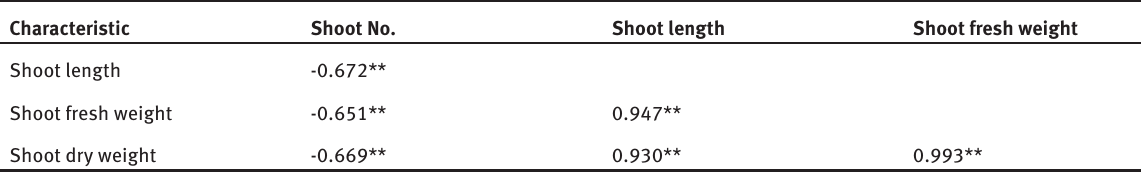
Table 2: Correlation coefficient between shoot multiplication characteristics.